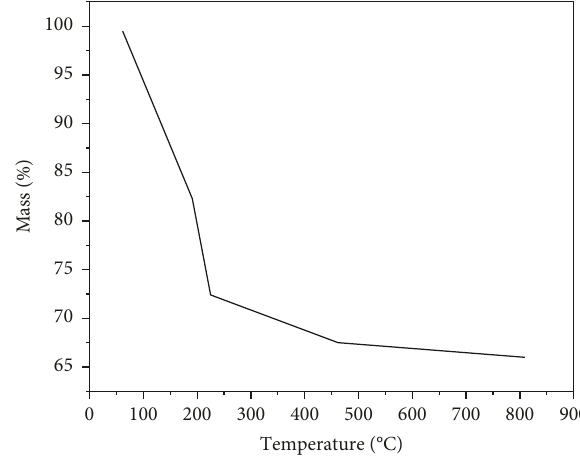
Figure 2: Thermogravimetric curve of the